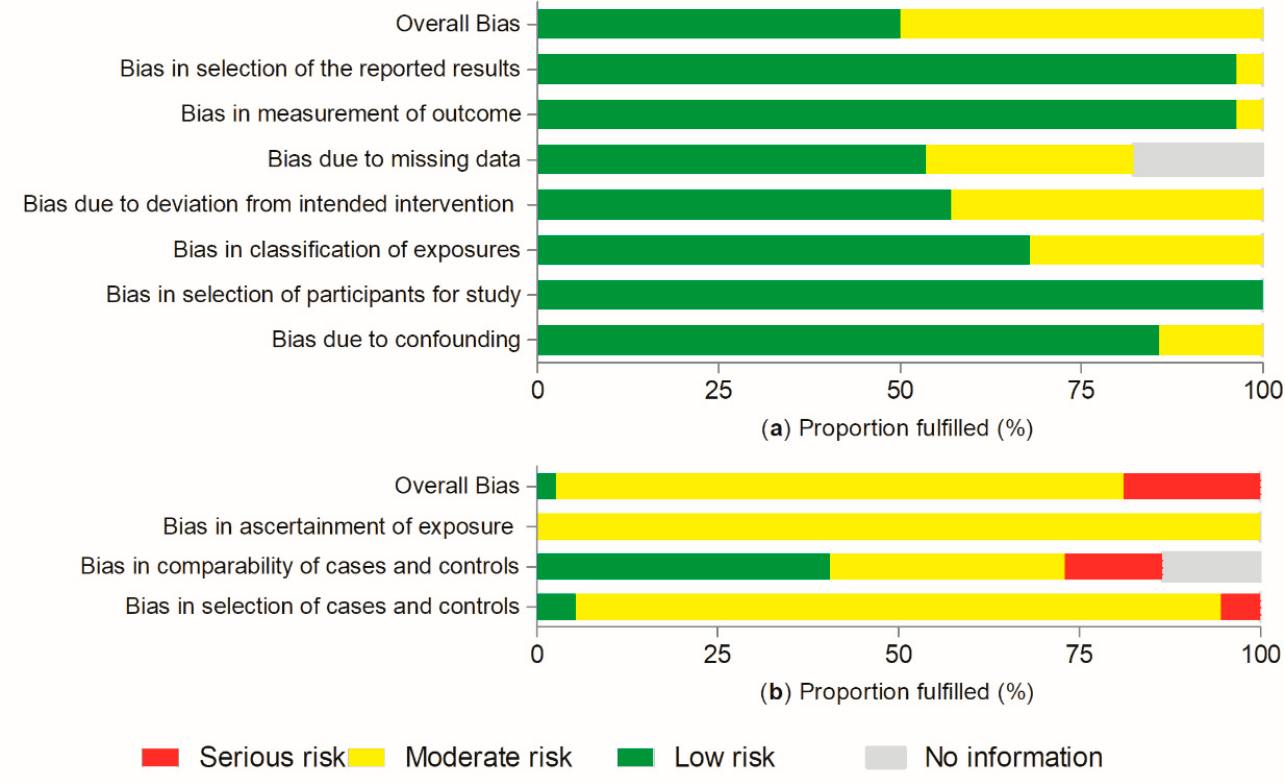
Figure 2. Risk of bias in the included studies. Legend: ( a ) risk of bias in cohort studies according to the Risk of Bias in Non-randomized Studies − of Exposures (ROBINS-E) tool and ( b ) risk of bias in case-control studies according to the Newcastle–Ottawa Scale (NOS).